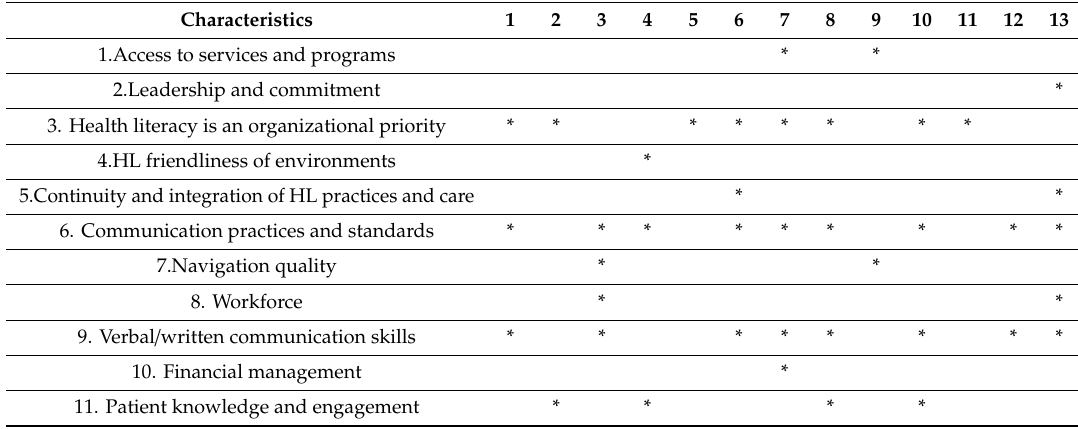
Table 4. Quality Improvement Characteristics of OHL